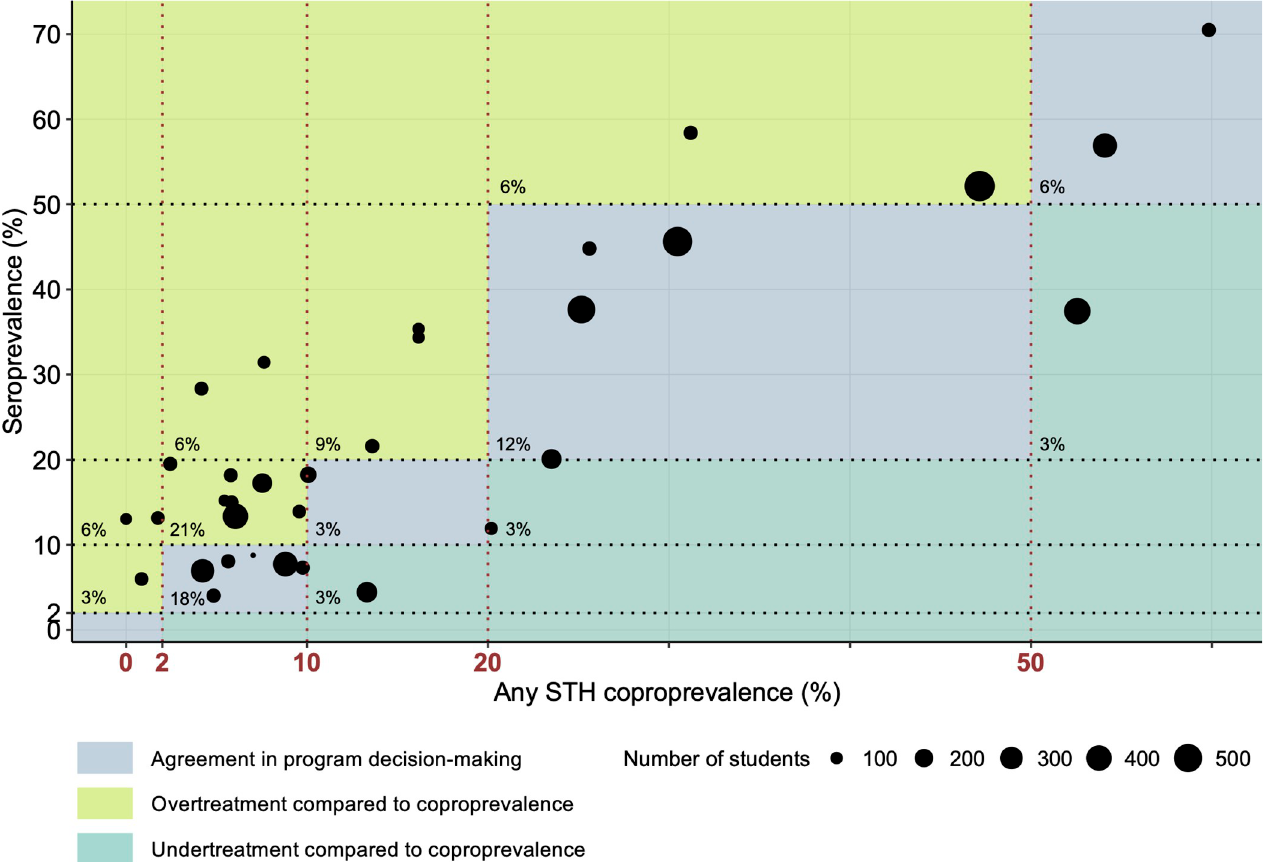
Fig 4. Program decision-making based on any STH coproprevalence and seroprevalence. Classification based on the program decision tree endorsed by the WHO during the implementation phase of a control program (prevalence � 50%: 3x MDA/year; 50% > prevalence � 20%: maintain MDA frequency; 20% > prevalence � 10%: 1x MDA/year; 10% > prevalence � 2%: 1x MDA/2 years; prevalence < 2%: no MDA) [15]. The WHO coproprevalence thresholds are indicated in red on the x-axis. The same thresholds were extrapolated to the seroprevalence data due to a lack of evidence-based alternatives. The size of the dots indicates the number of screened students per woreda. The percentage of woredas ranked in a certain category is shown in the left bottom corner.